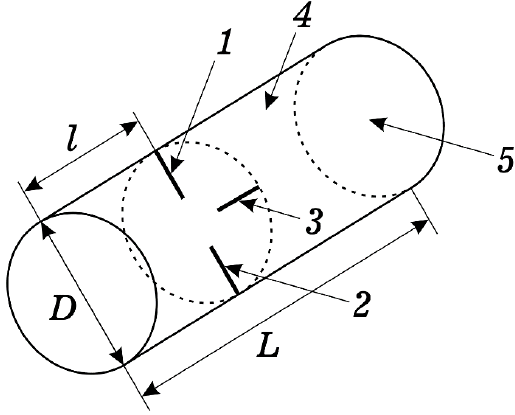
Figure 7. Design of a holographic subsurface radar antenna [59]. The drawing shows the main elements of the design, as described in the following: (1) emitting feed antenna, (2) receiver feed antenna for parallel polarization, (3) receiver feed antenna for cross-polarization, (4) round waveguide, and (5) open end of waveguide. The dimensional parameters are D — waveguide diameter, L — waveguide length, and l — distance between the closed end of the waveguide and the plane of pin antennas 1 and 2.